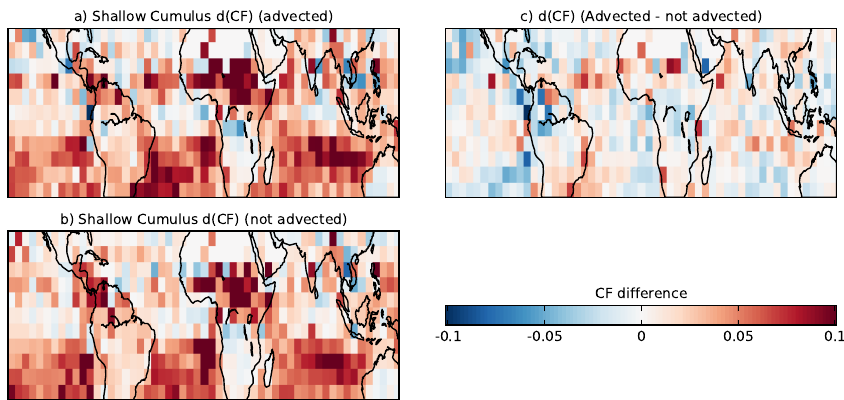
Fig. 7. The difference in the CF at the end of the timestep between the high AI and low AI populations ( d (CF)). This figure shows the difference when advection is taken into account using HYSPLIT (a) , when the effects of advection are neglected (b) and the difference between them (c)